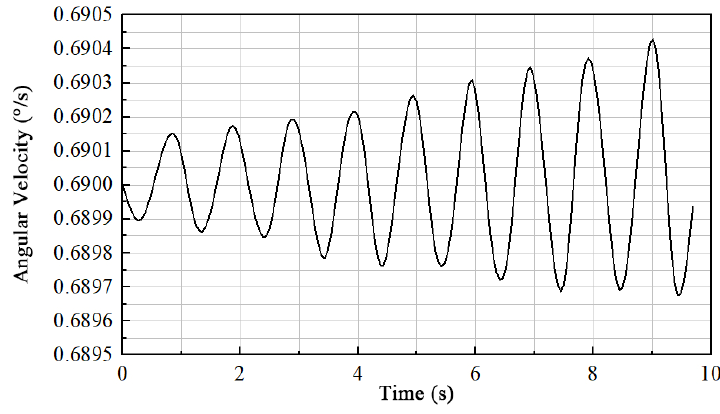
Figure 7. Luffing Angular Velocity of Bottom Node.